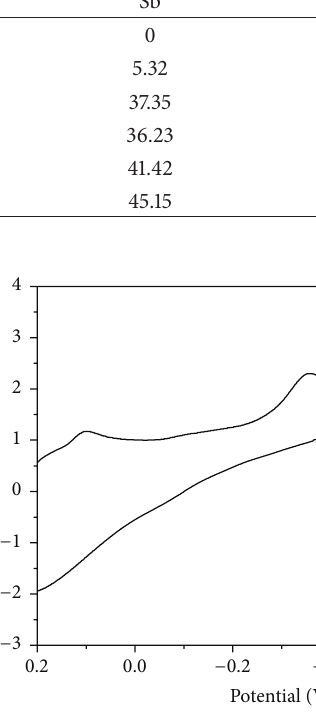
Figure 4: Cyclic voltammetry curve of 0.3 M KI, 0.01M Bi 3+ , 0.01M Sb 3+ , and 0.01 M Te 4+ in ethylene